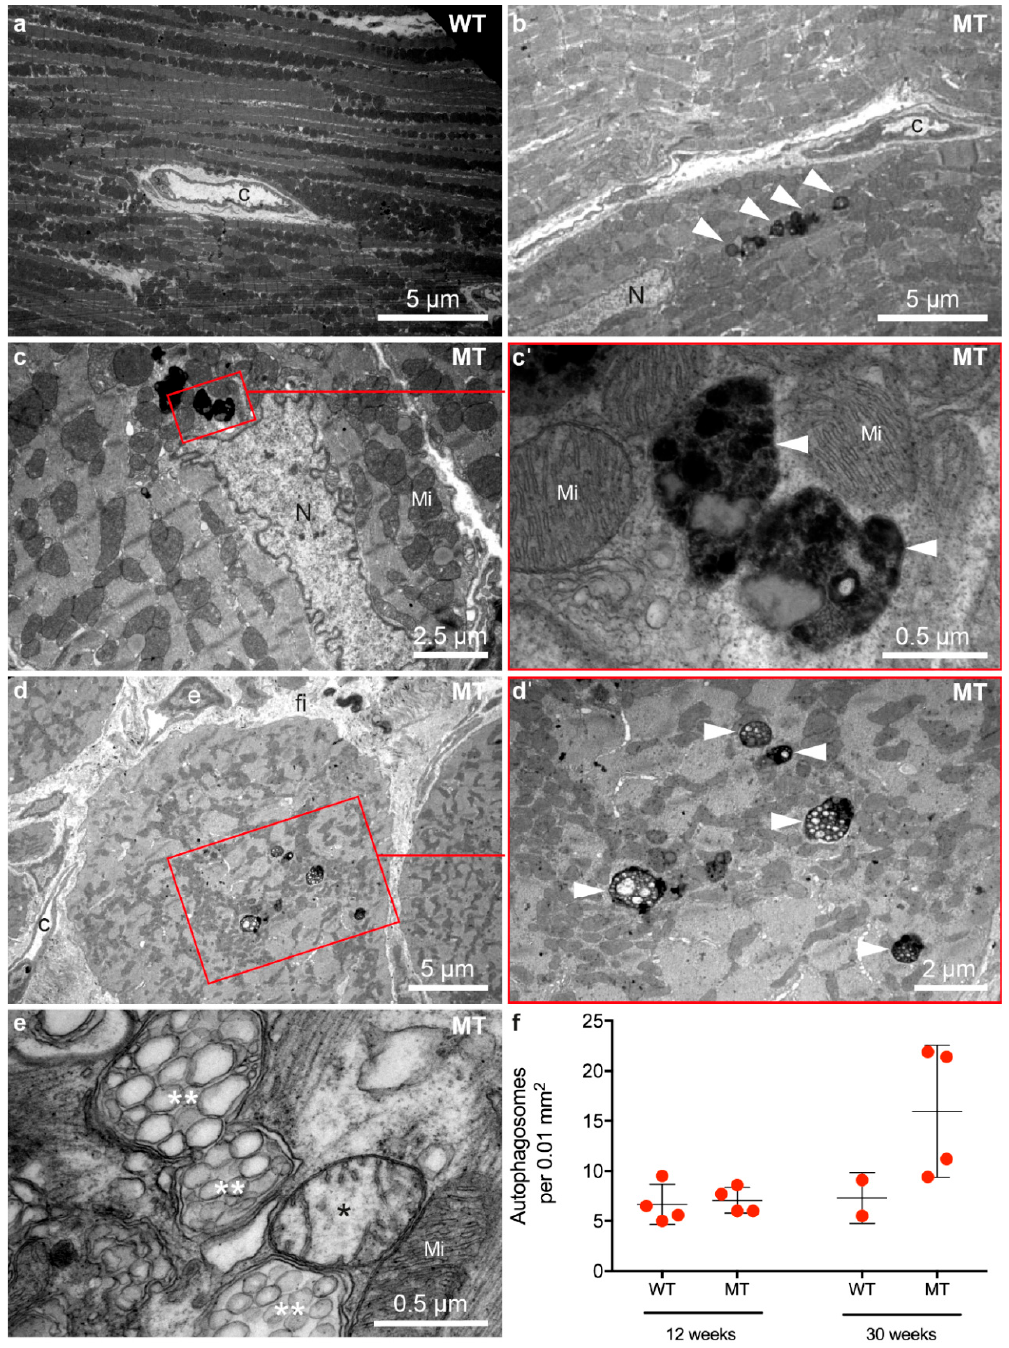
Figure 5. Cardiomyocytes contain an increased number of autophagosomes and autolysosomes during the chronic phase of AC. Micrographs in ( a , b , d , e ) show right ventricles and ( c ) shows the left ventricle. Transmission electron microscopy reveals that cardiomyocytes of 30 week-old Dsg2 MT mice (MT) contain more autophagosomes and autolysosomes (white arrowheads; ( b – e , c ′ , d ′ ) are magnifications of the marked area an ( c , d ), respectively) than wild-type controls (( a ); WT). The autophagosomes contain electron-dense cytoplasmic components and degenerated cellular organelles. ( e ) Mitochondria with rarefied cristae (*) and swollen mitochondria with vesicular cristae (**) indicate mitochondrial damage during chronic disease progression. C, capillary; fi, fibrosis; Mi, normal mitochondrion; N, nucleus. Quantification of autolysosomes at the age of 12 and 30 weeks is shown in ( f ). Due to the limited number of examined animals no statistical analysis was carried out. Representative electron microscopic images of 12 week-old mice are depicted in Supplemental Figure